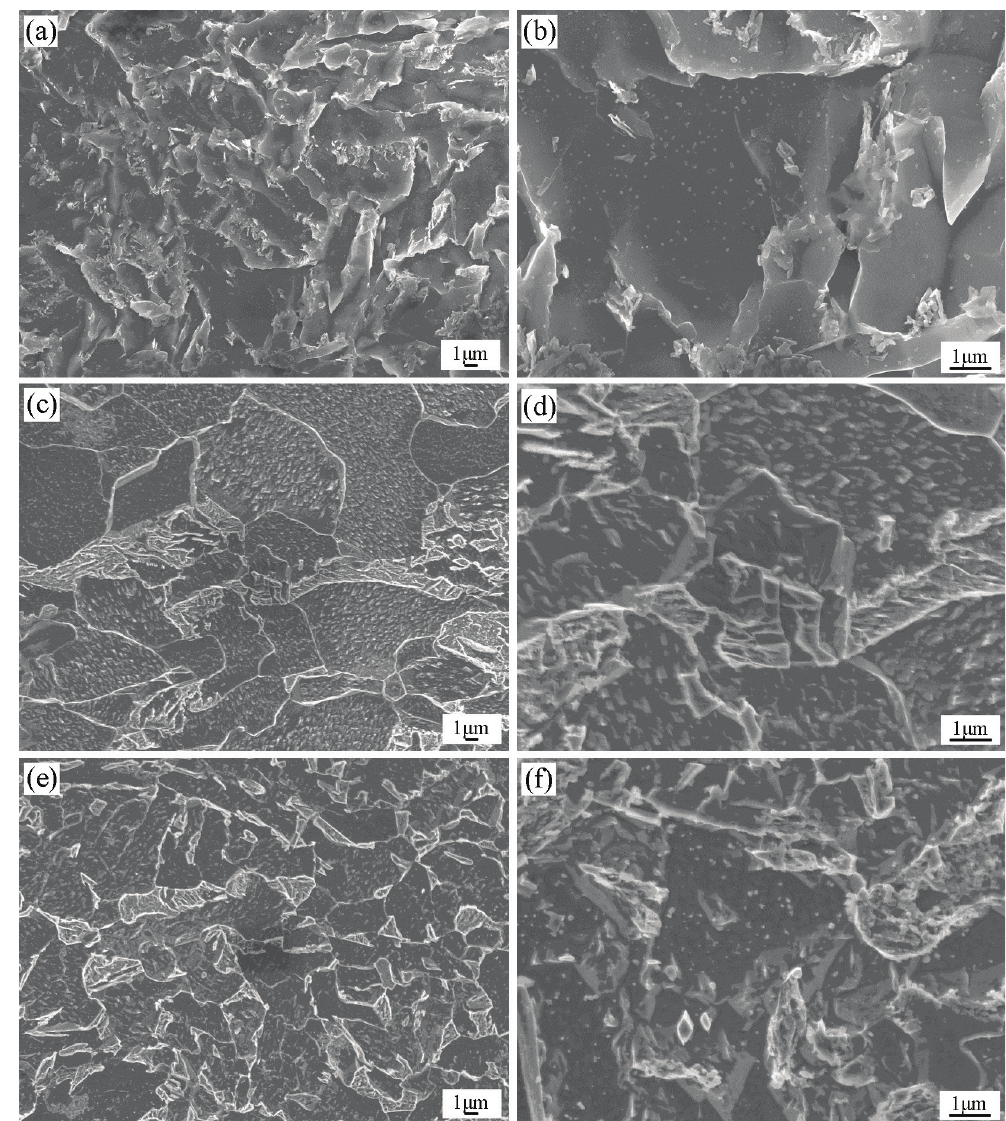
Figure 1. SEM images of experimental steels (a)(b) Steel 1; (c)(d) Steel 2; (e)(f) Steel